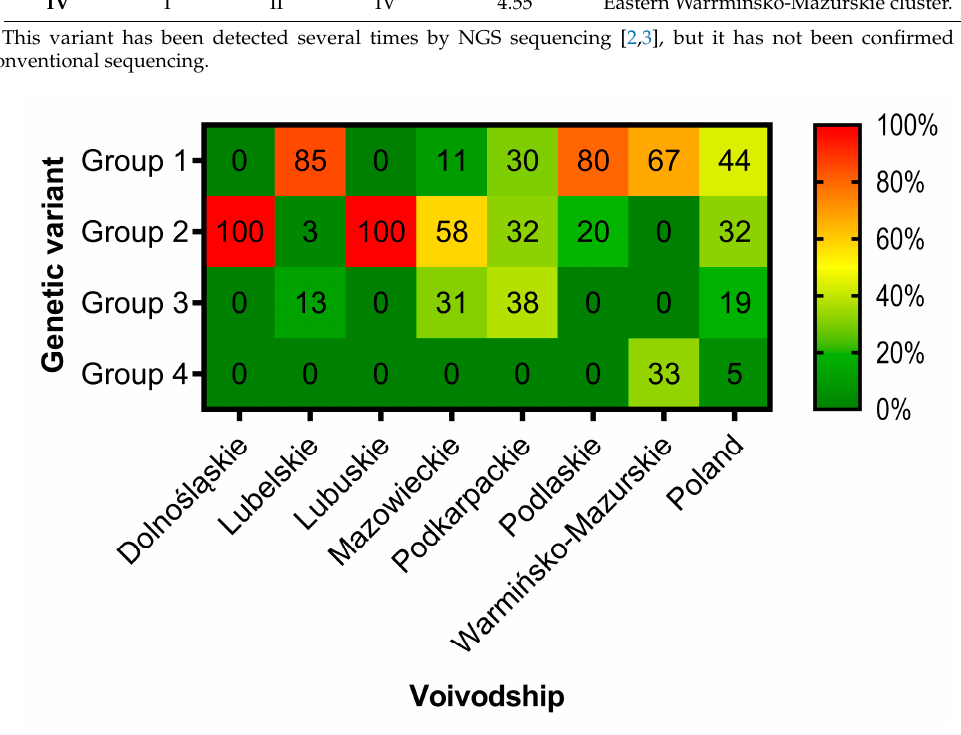
Figure 4. Frequency of determined ASFV genetic groups in Poland, 2017–2020. Each voivodship is presented